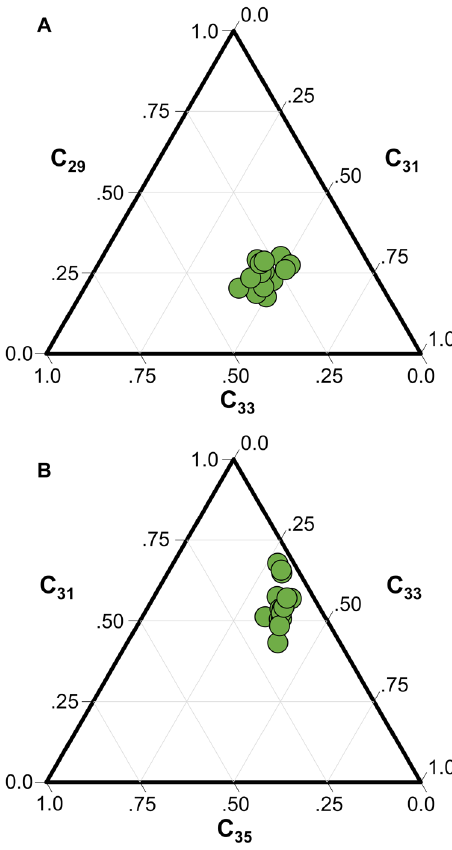
Fig. 2 Ternary diagrams for higher-chain n -alkane relative